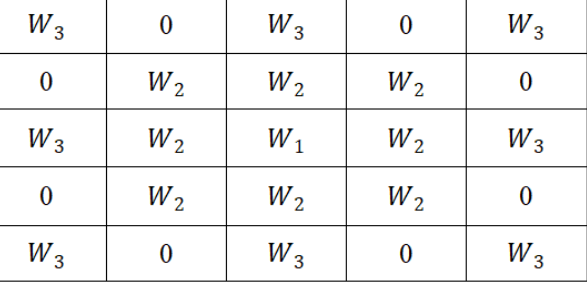
Figure 6. Franctional differencial